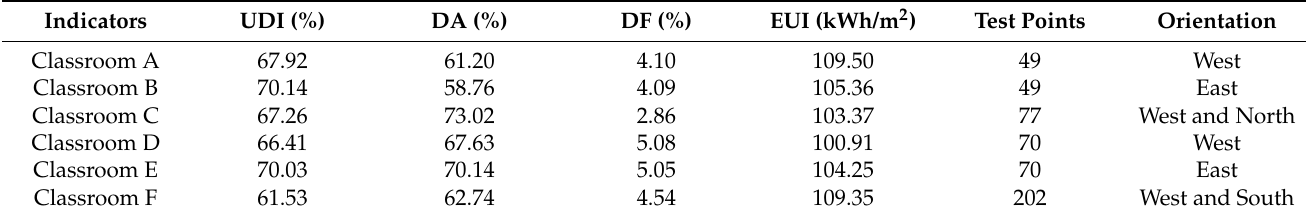
Table 4. Data recording of six classrooms’ indoor test